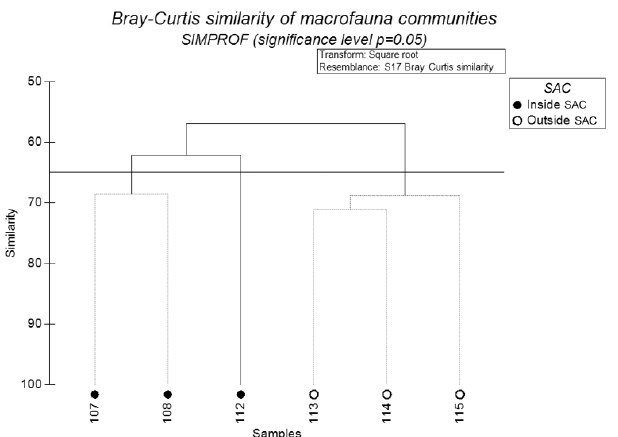
Fig. 4. Cluster analysis and SIMPROF test of macrofaunal species compositions inside ( • ) and outside ( ◦ ) the SAC. Dotted lines are connected stations that did not show statistical differences in the multivariate community structure.